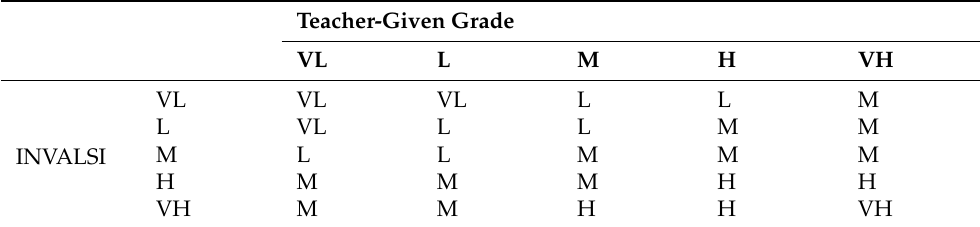
Table 4. The inference rules.